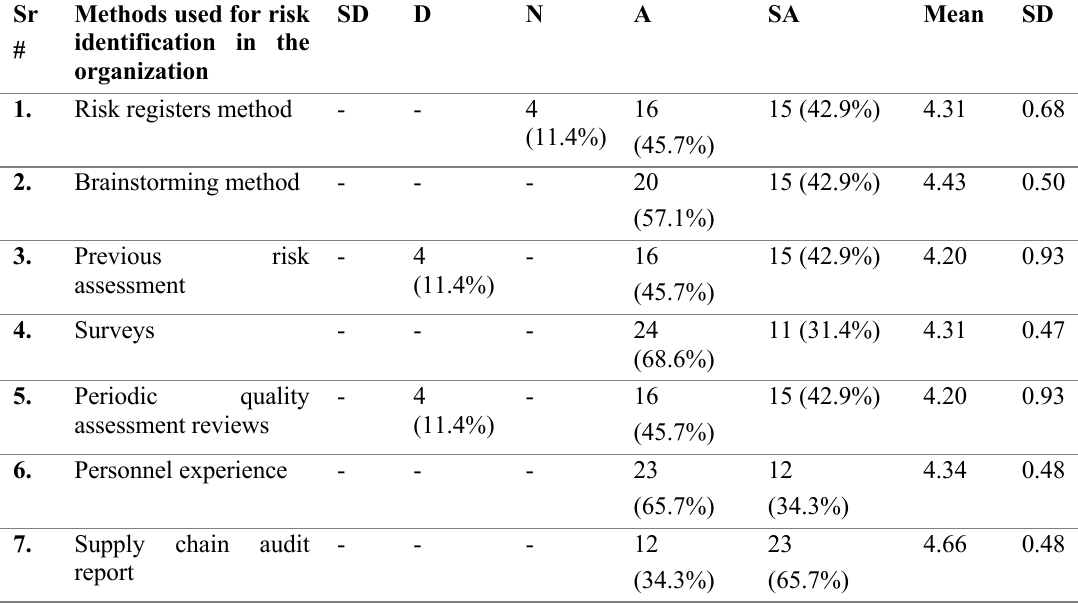
Table 2: Method used for risk identification in the organization that effect organization performance Sr